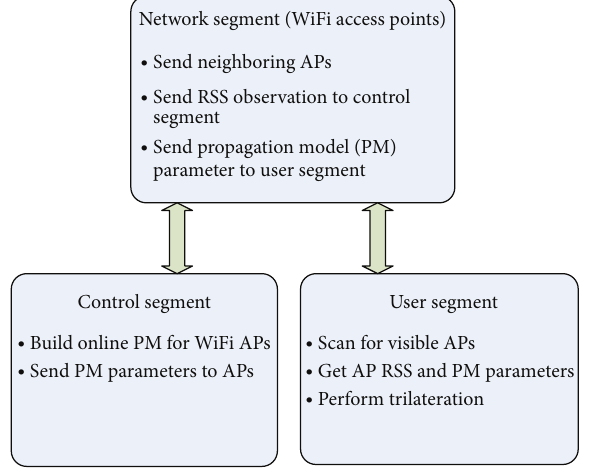
Figure 9: Simplified block diagram